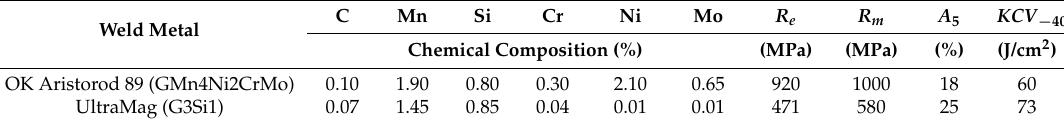
Table 4. Selected properties of welding materials used for welded joints of Hardox 600